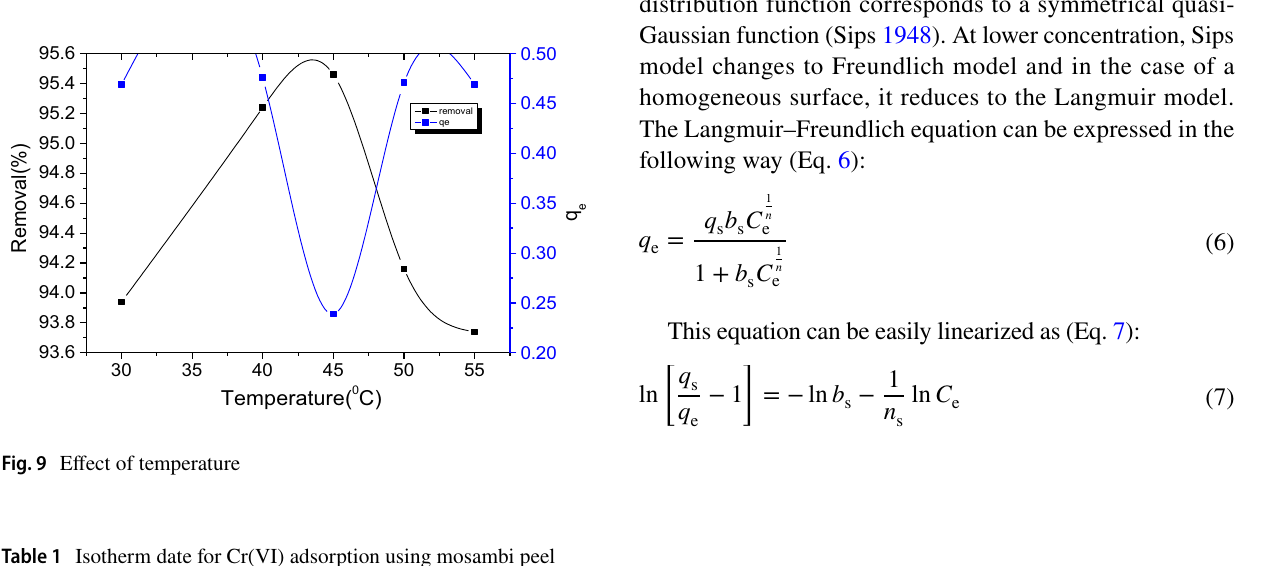
Table 1 Isotherm date for Cr(VI) adsorption using mosambi peel Adsorption